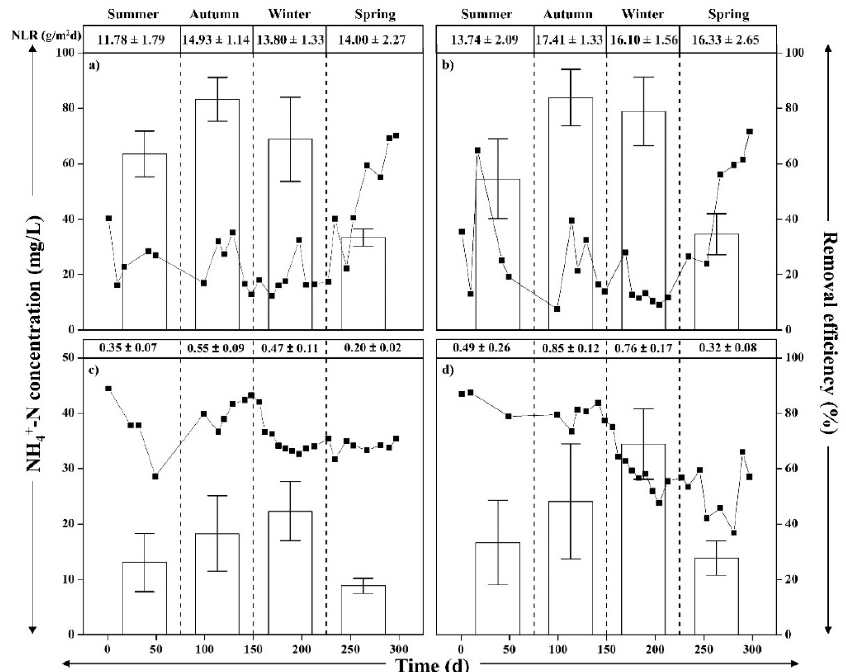
Figure 4. Effluent average NH 4+ -N concentration (bars) and removal efficiencies (points): ( a ) VSSF 1; ( b ) VSSF 2; ( c ) HSSF 1; and ( d ) HSSF 2.NLR: nitrogen loading rate.